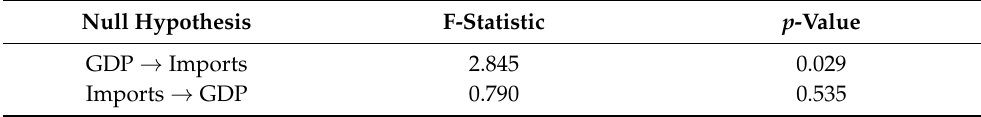
Table 1. Granger Causality Test, PRC, 4 lags, 2000–2021.